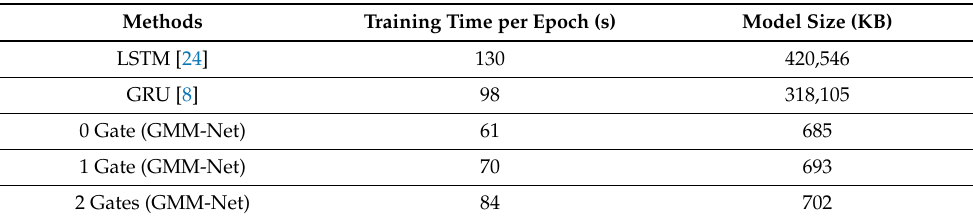
Table 2. Train time and model size of